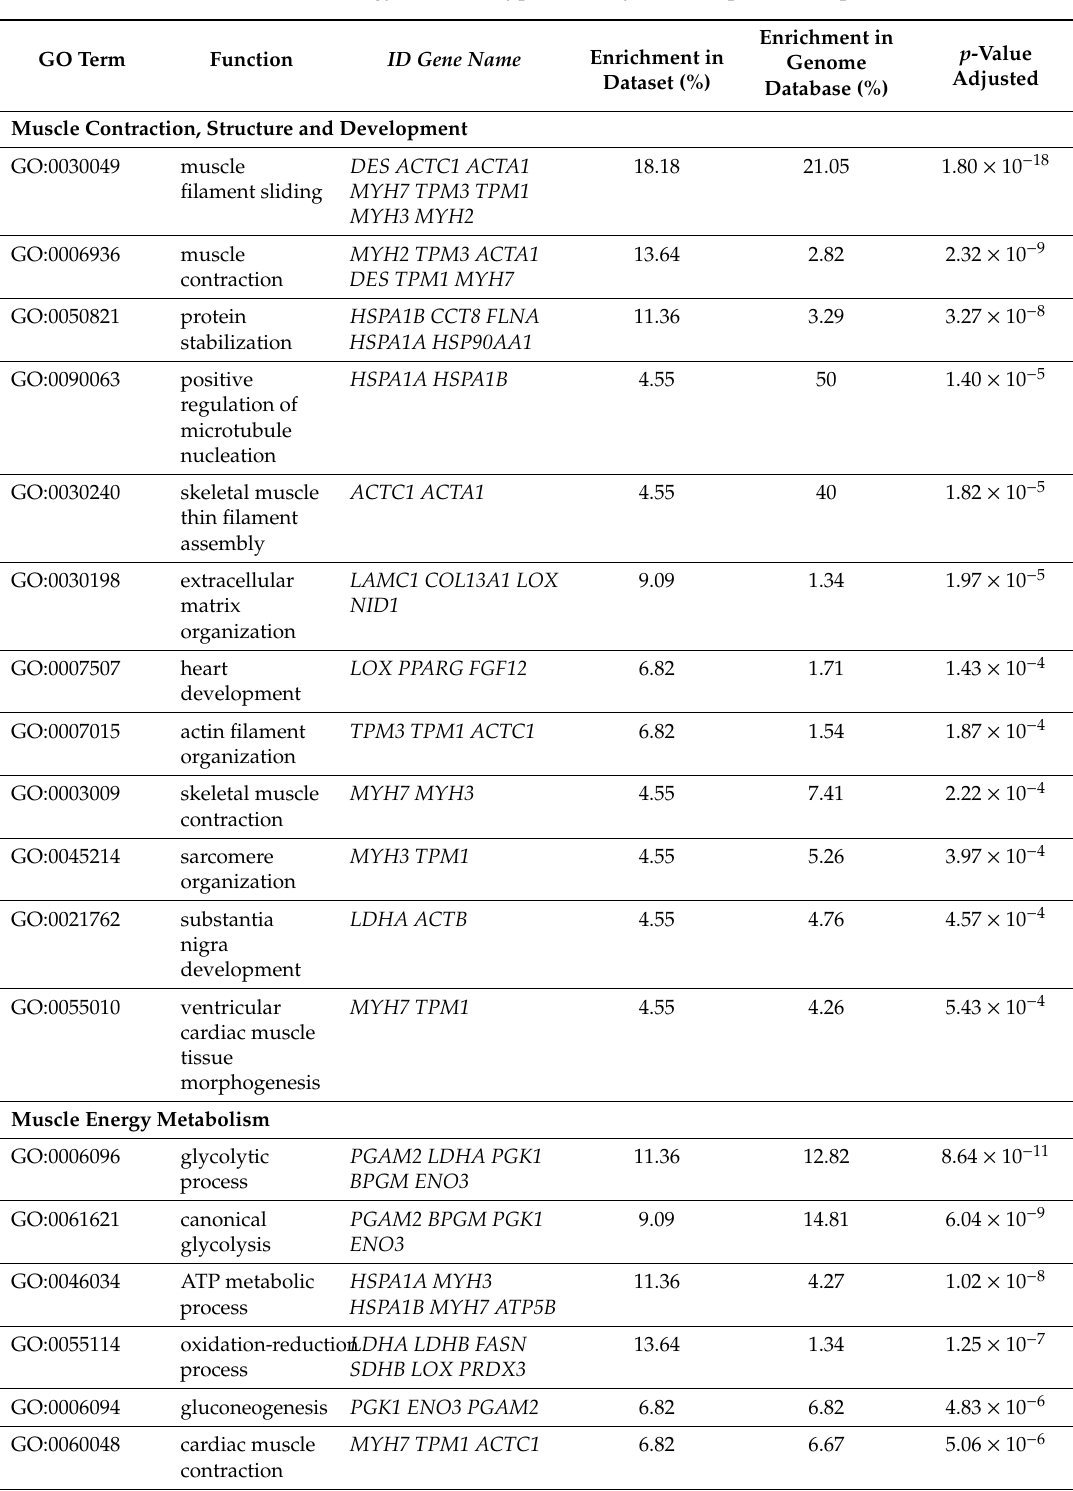
Table 5. Gene Ontology of the 44 hypothetically secreted proteins in